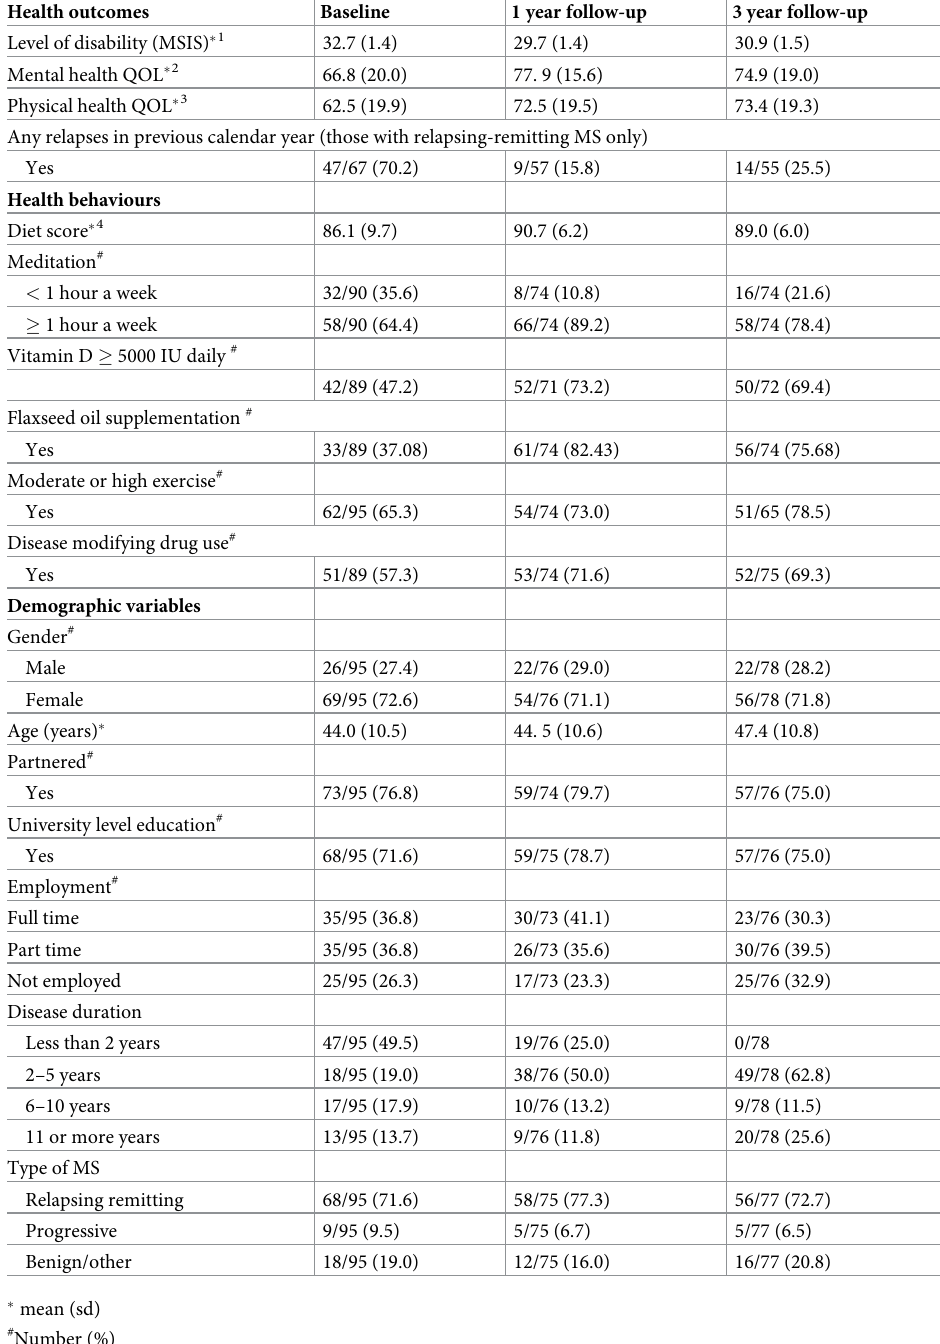
Table 2. Sample description over